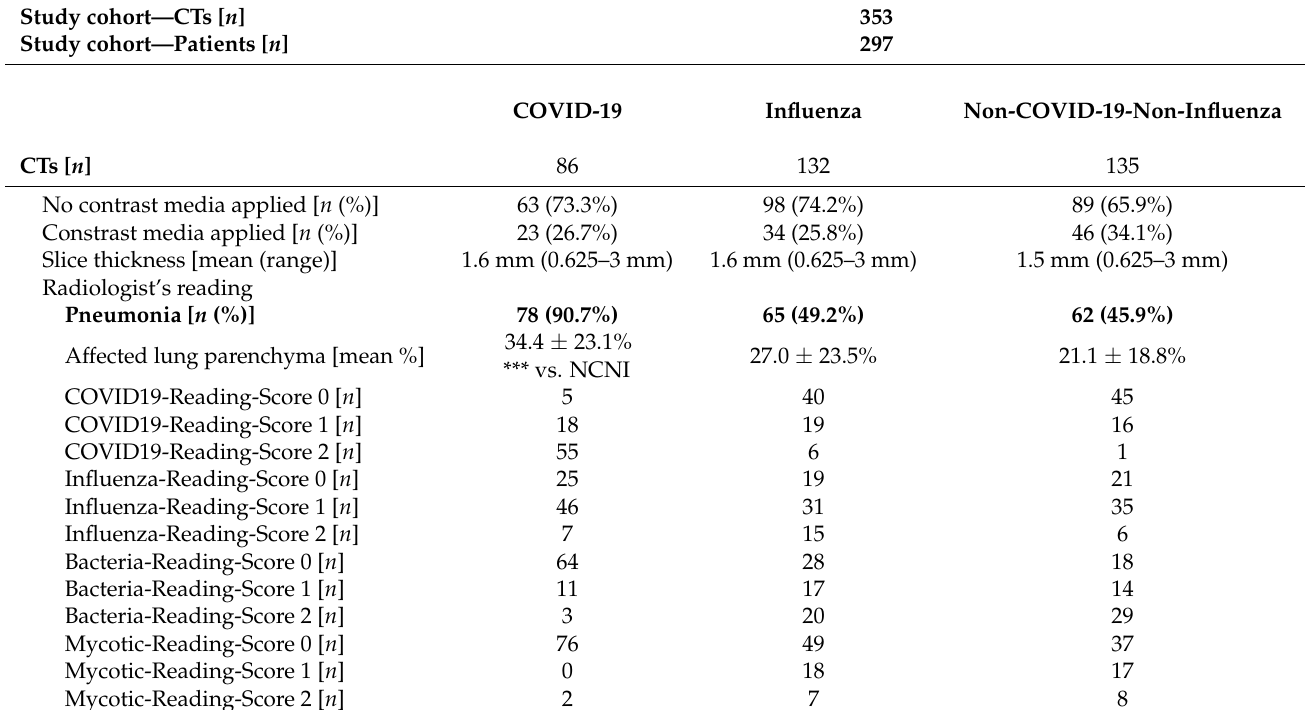
Figure 1. Flow chart illustrating patient identification. Patients presenting in the emergency department (16 March to 12 April 2020, first COVID-19 pandemic wave in Germany) were included and divided into subgroups according to RT-PCR results. Additionally, patients with confirmed influenza infection before the COVID-19 outbreak (2018/2019) were included. Patients with pneumonic CT features were divided into subgroups according to RT-PCR results for Severe Acute Respiratory Syndrome Coronavirus 2 (SARS-CoV-2) and influenza. Follow-up CTs not considered (compare Table 1). Table 1. Subgroup characteristics.